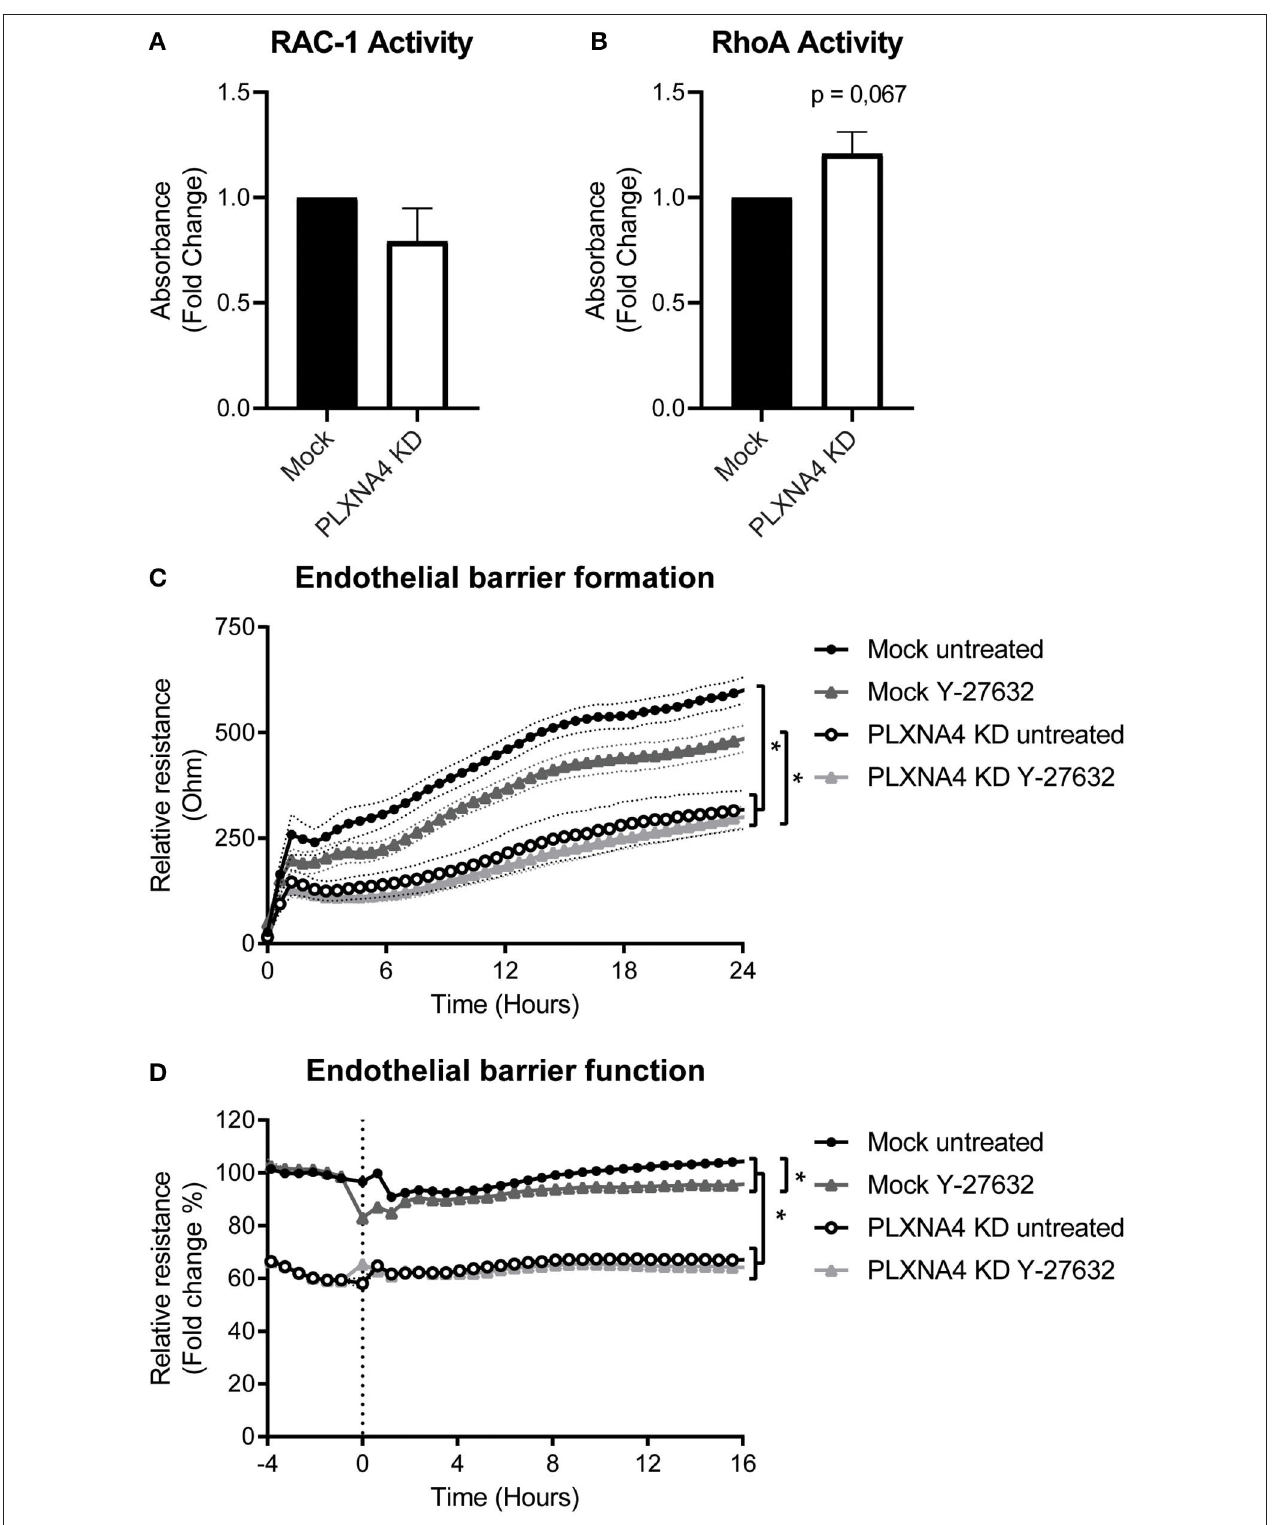
FIGURE 6 | Loss of endothelial PLXNA4 affects RhoA/ROCK pathway activity. (A,B) Activity of the small GTPases (A) RAC-1 or (B) RhoA in mock-treated or PLXNA4 KD endothelial cells. Results are expressed as fold change in absorbance compared to control cells, set at 1. Mean ± S.E.M. of N = 8, * P < 0.05. (C,D) Effect of 10 µ M Y-27632 ROCK inhibitor on (C) barrier formation and (D) barrier function of mock control cells or PLXNA4 knockdown cells. Results are expressed as or as percentage of the average resistance of untreated control cells, respectively. Mean resistance ± S.E.M. of N = 3, * P < 0.05.